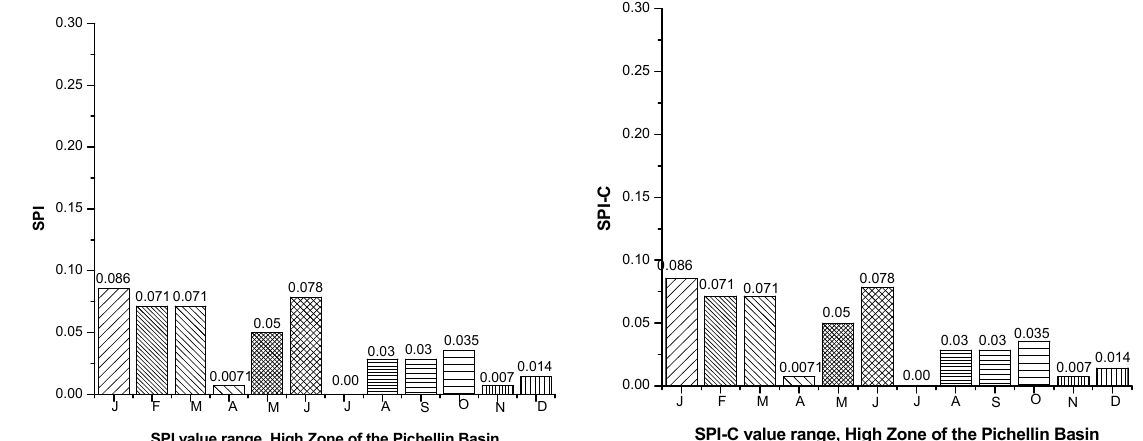
Figure 14. Comparative SPI and SPI-C, high zone of the basin.